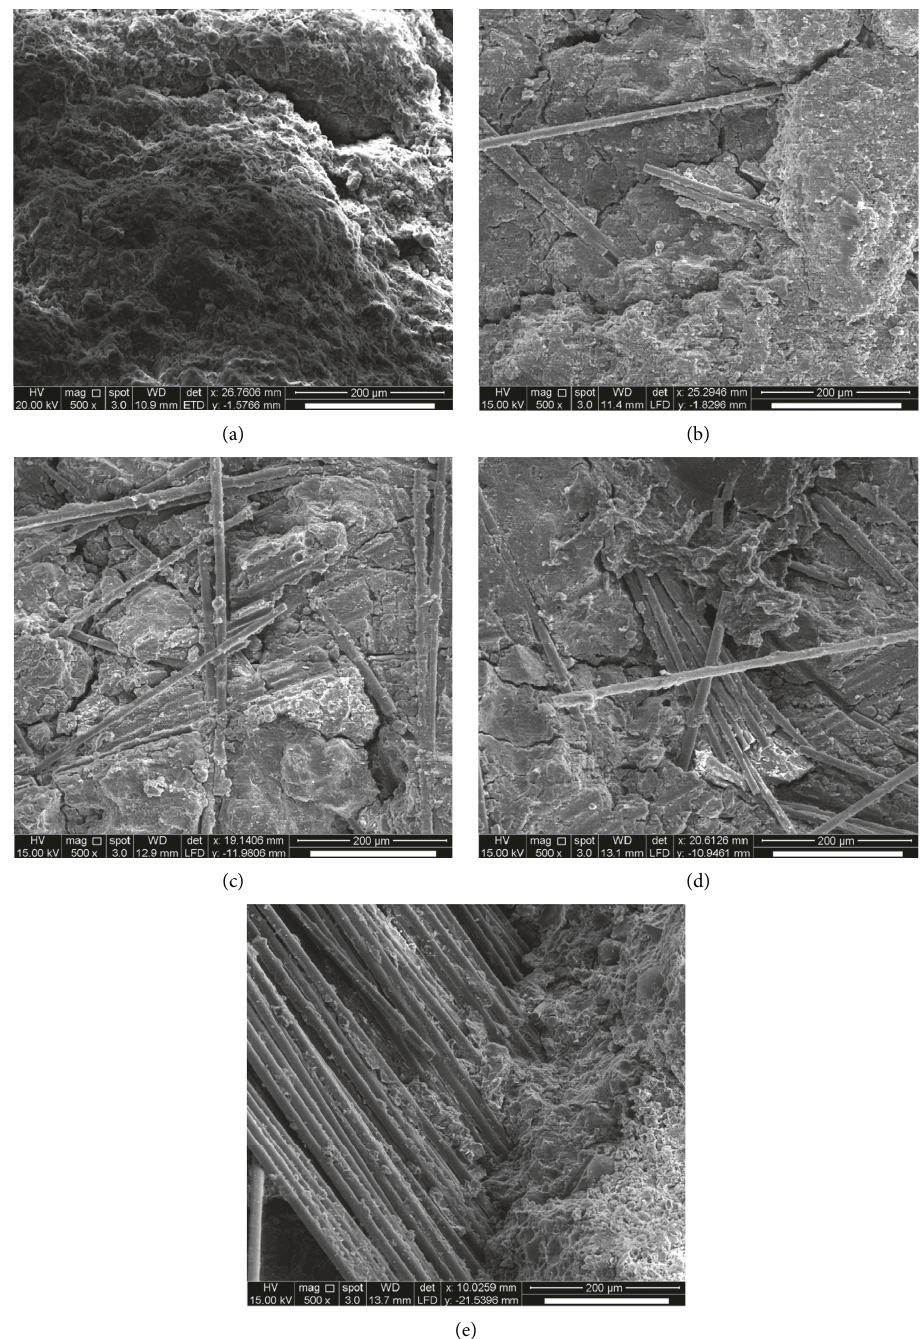
Figure 21: SEM images of cement-fly ash-stabilized soil with different basalt fiber contents. (a) BF � 0%. (b) BF � 0.3%. (c) BF � 0.6%. (d) BF � 0.9%. (e) BF �